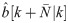
Constraint relaxation scheme in a variable horizon problem.For k = 1, the binary variable b^[k+N¯|k] is set in the horizon N⋆[k = 1], when x^[k+N¯|k]∈Q. In k = 2, the agent repeats another instance of the same variable horizon problem, which now sets variable b^[k+N¯-1|k], as x^[k+N¯-1|k]∈Q for N⋆[k = 2].